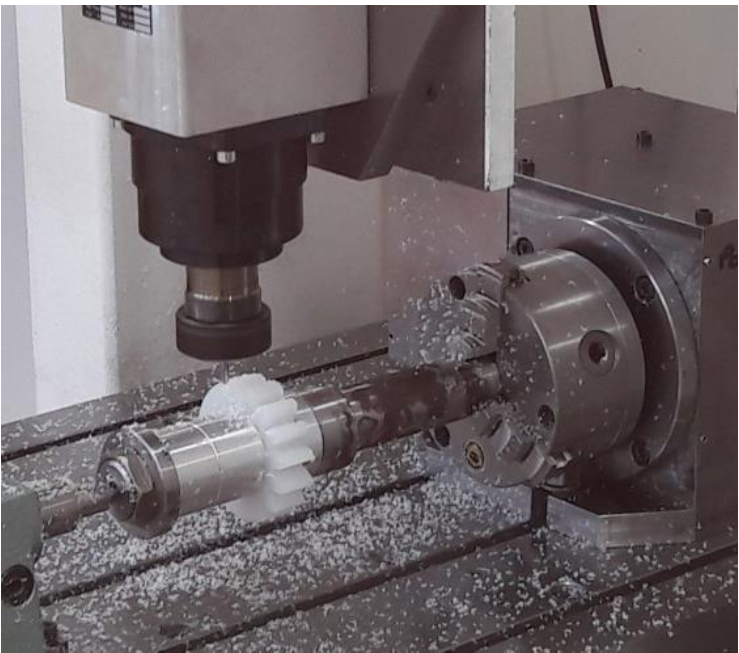
Figure 2. Machining the gear, material PE 1000 after heat treatment.